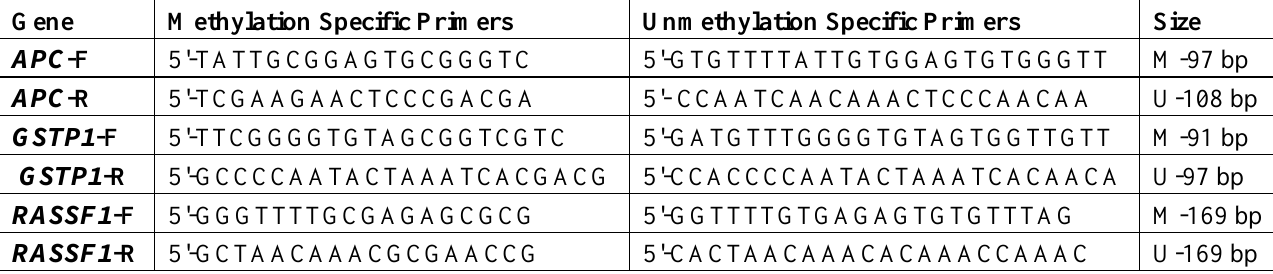
Table 3. Methylation and Unmethylation MSP Primer Sequences for Breast